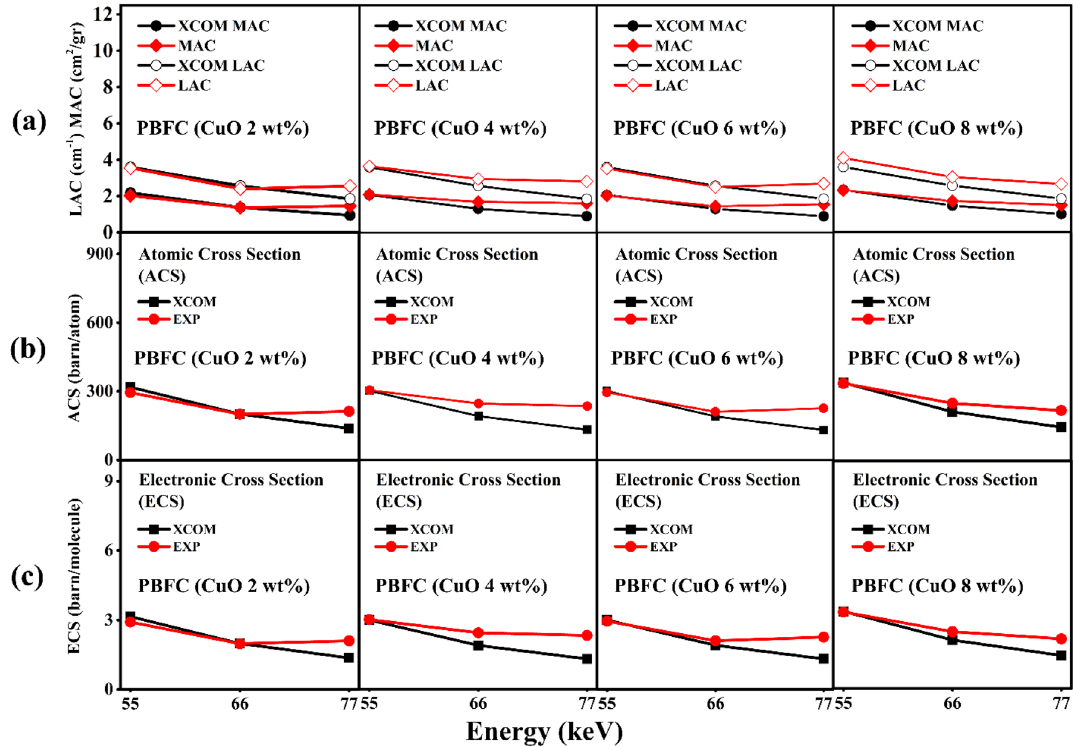
Figure 2. The linear (LAC) and mass attenuation coefficient (MAC) ( a ), atomic cross section (ACS) ( b ), and electronic cross section (ECS) ( c ) of shielding PBFC for various amount of CuO in composite for energy 55, 66, and 77 keV. We have included the theoretical calculation (XCOM) database for comparison.